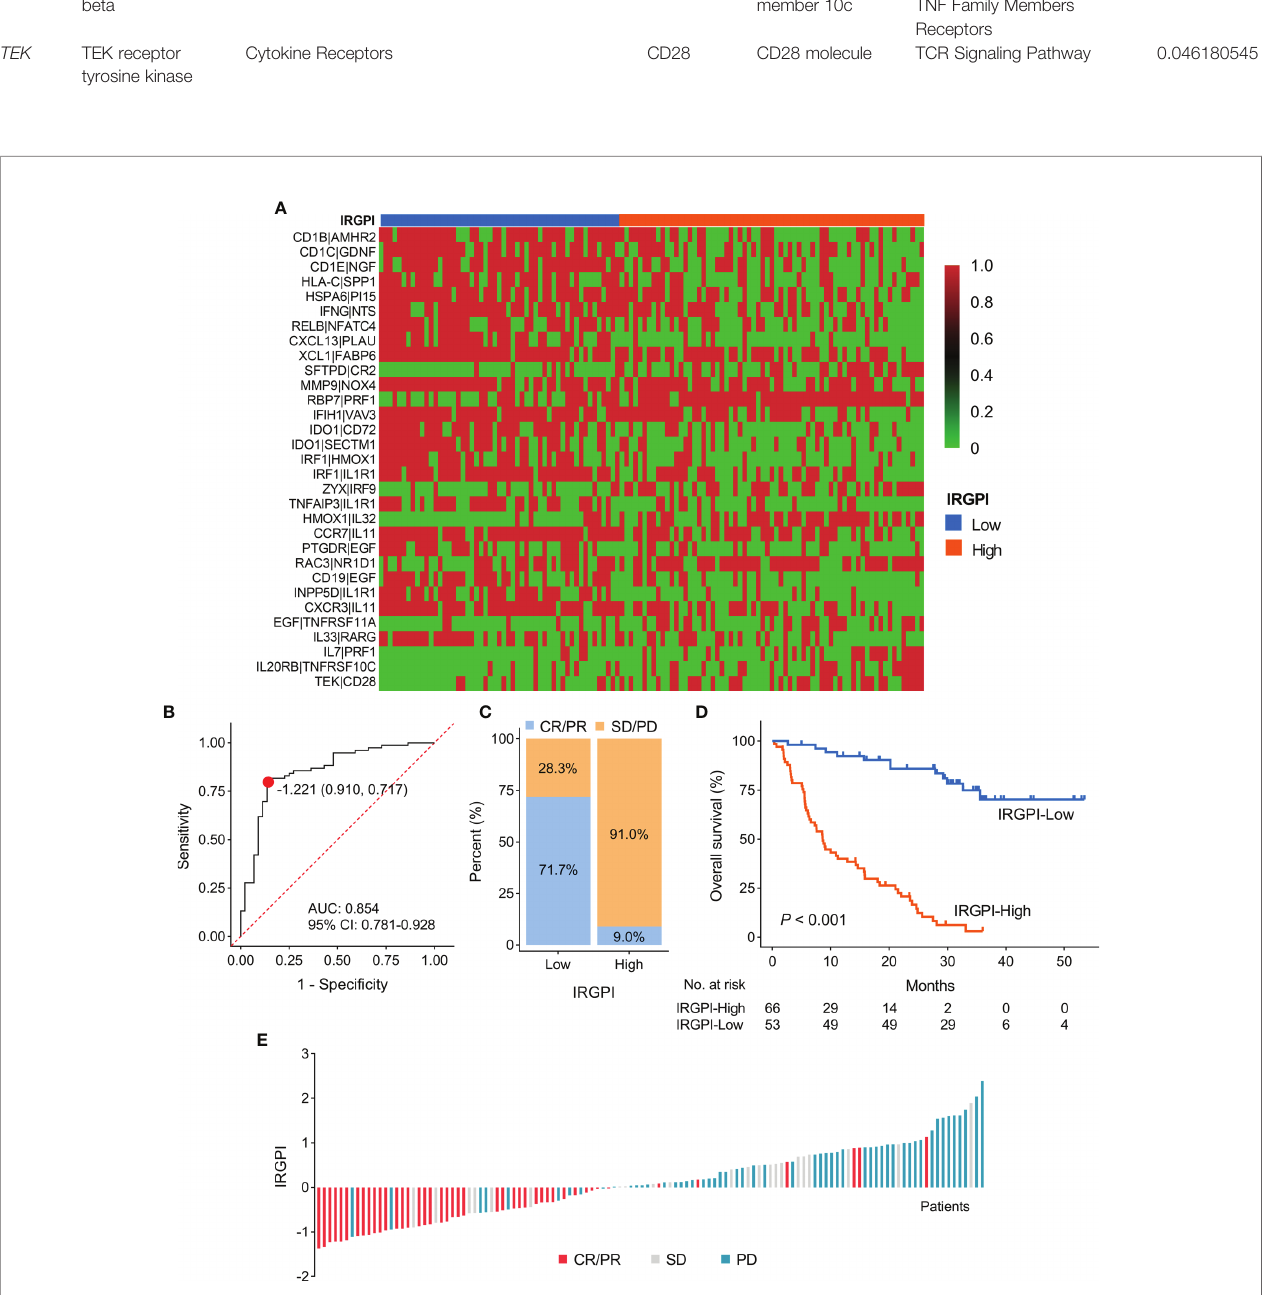
FIGURE 2 | Construction and evaluation of IRGPI in the discovery cohort. (A) A heatmap of the identi fi ed 31 IRGPs with corresponding IRGPI groups. (B) ROC curve for the predictive performance of IRGPI. (C) The rate of durable clinical response for patients with high and low IRGPI scores. (D) Kaplan-Meier plots of overall survival segregated by IRGPI score with cut-off points selected according to the Youden index. (E) Waterfall plot of IRGPI for distinct clinical response groups. IRGPI, immune-related gene pair index; IRGPs, immune-related gene pairs; ROC, receiver operating characteristic; AUC, area under curve; CI, con fi dence